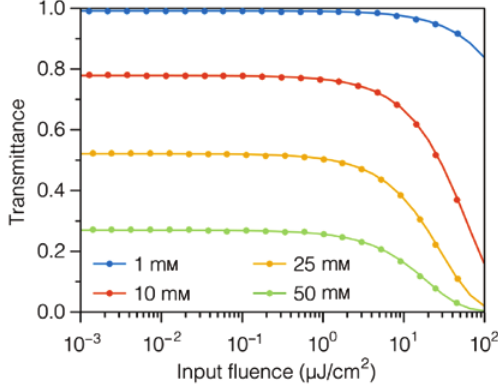
Figure 4: Transmittance vs. pump fluence using full-wave atomic system simulations (solid lines) vs. BLL (dotted lines) at different molecule